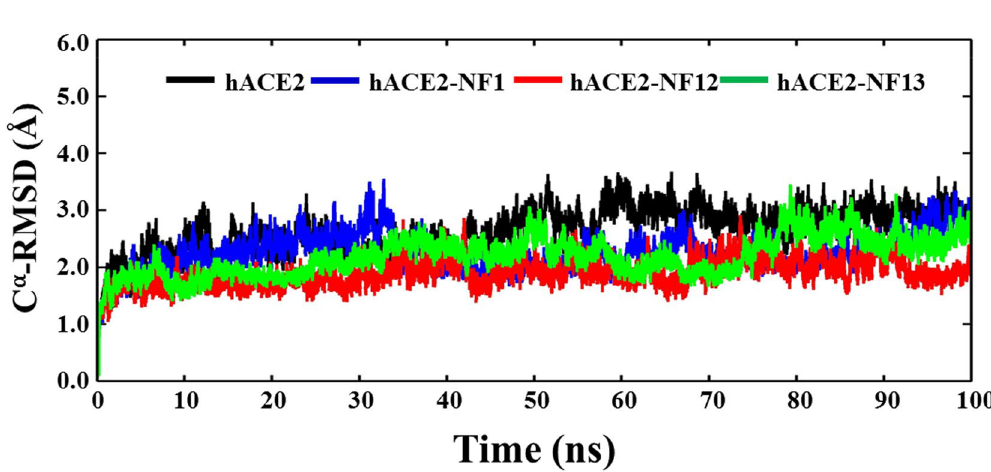
Figure 2. The backbone C α -RMSD plots reflecting the conformational stabilities of ACE2 (black) and docked complexes with ligands, NF1 (blue), NF12 (red), and NF13 (green). A similar color scheme is used to represent the plots for protein and protein–ligand complexes from Figs. 2, 3, 4, 5, 6 and